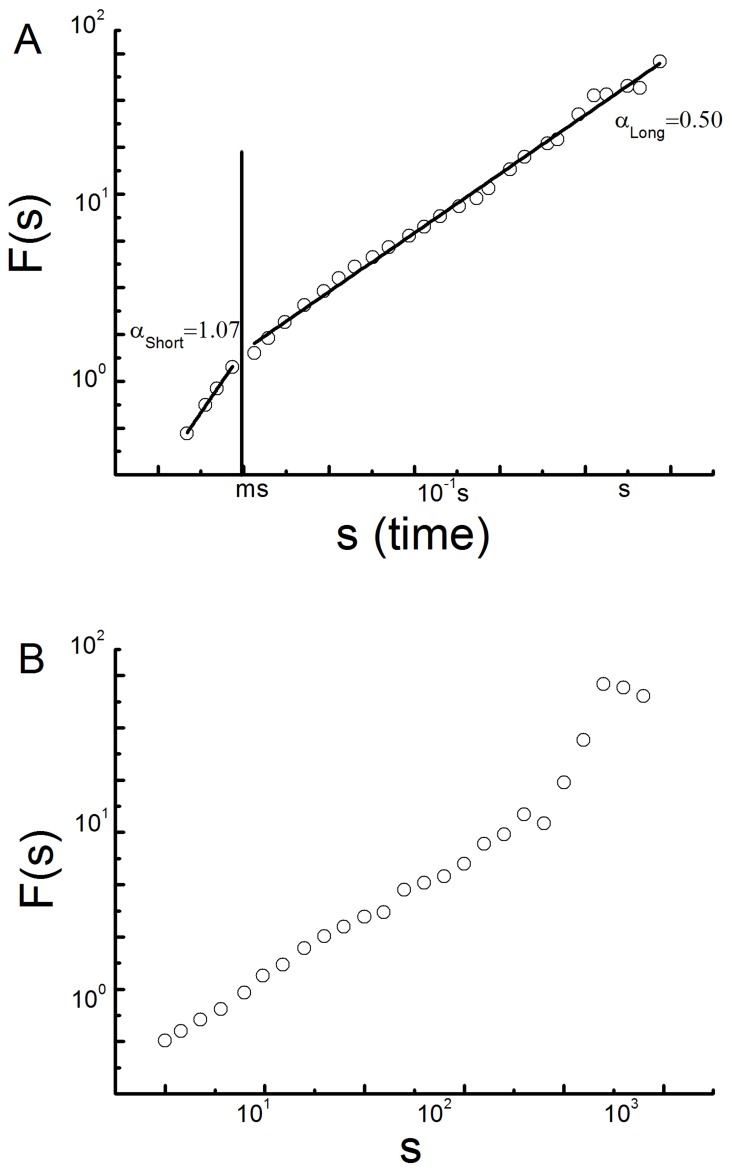
Comparison of A) EMD-DFA, and B) conventional DFA of standing postural sway dynamics (i.e., center-of-pressure) as a 23-year-old subject stood with eyes-open.Two distinct linear regions were present in the EMD-DFA-derived double log plot, thereby enabling calculation of a short- and long-term scaling exponent, α. The double log plot derived from the conventional DFA, on the other hand, did not contain a clear cross-over point. Similar results were observed for all analyzed datasets.